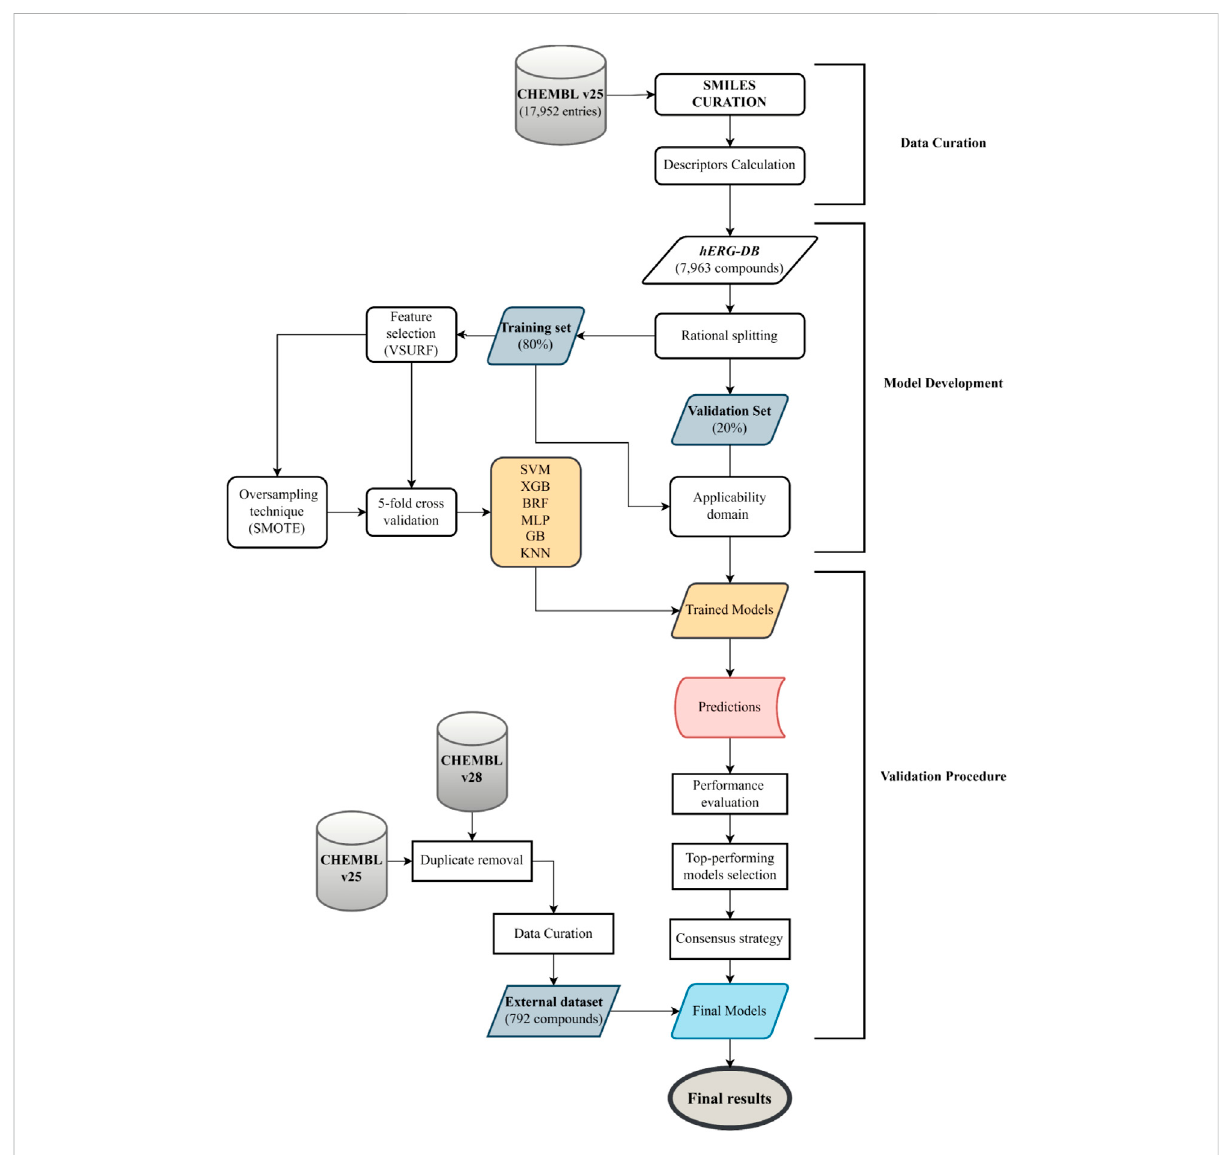
FIGURE 2 Flowchart showing the main steps of the adopted computational work fl